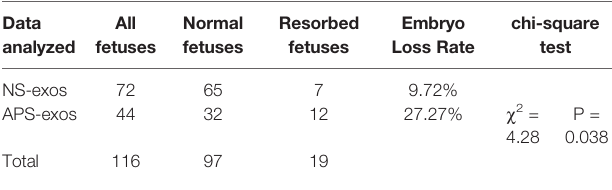
TABLE 2 | Embryo loss rate of antiphospholipid syndrome-exosomes (APS-exos) and control (NC)-exos immunized mice (P = 0.038). Data analyzed